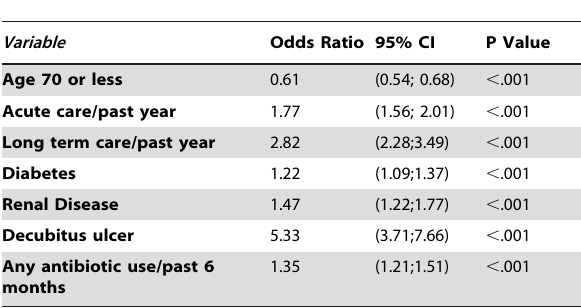
Table 2. Multivariable model of risk factors for patients with an always or intermittently colonized compared to a never colonized nasal MRSA carriage pattern at 30